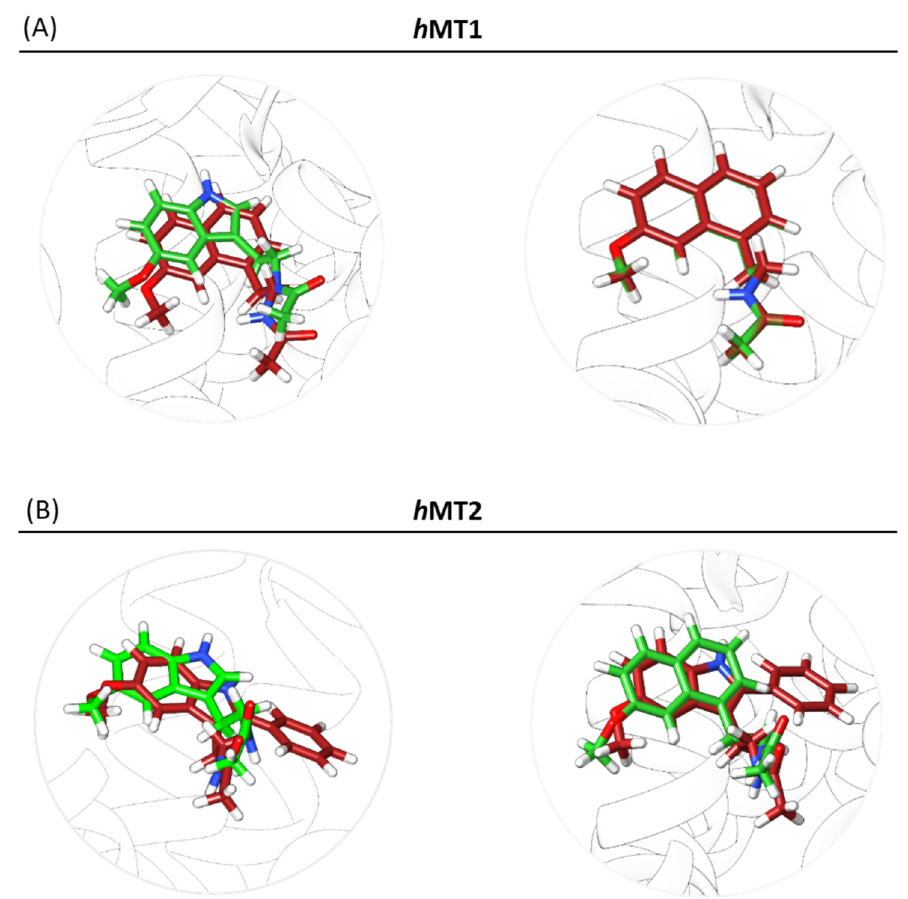
Figure 6. Docking poses of melatonin and agomelatine in hMT1 and hMT2 orthosteric sites. As a reference, the crystallographic conformation of agomelatine in 6ME5] for hMT1 ( A ) and melatonin in 6ME9] for hMT2 ( B ) are reported in red. The tested docked ligands are highlighted in green (melatonin on the left side, agomelatine on the right in both A,B sections).